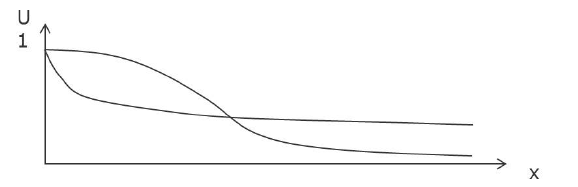
Figure 6: The set H A of subrequirements is divided into examined and unexamined require- ments. Initially, all requirements in H A are unexamined such that U A (0) = H A and E A (0) = ∅ . When effort x A is increased, the set E A ( x A ) will grow and U A ( x A ) will decrease.